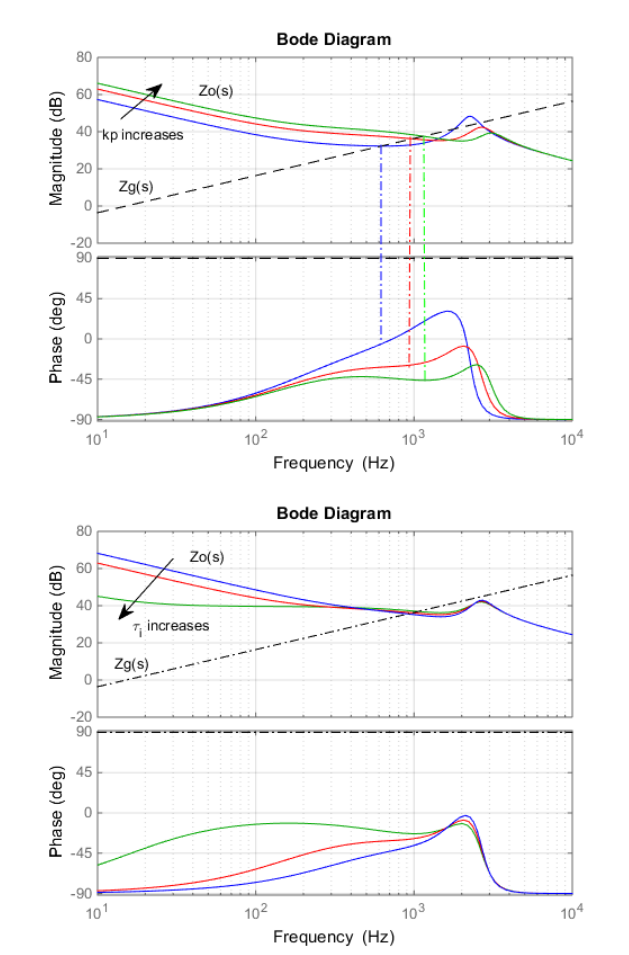
Fig. 6. Bode plot of inverter output impedance and grid impedance (a) proportional gain changes (top) (b) integral gain changes (bottom)